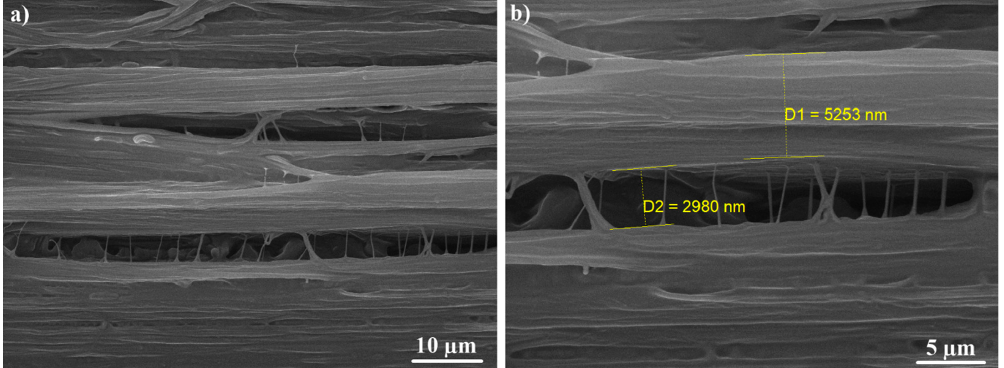
Figure 9. SEM images of fibrillar structure with different magnifications for UHMWPE/PE-wax films at a PE-wax content of 1.0 wt.% with a draw ratio value of 33 obtained by second thermal regime. Tensile direction is horizontal.